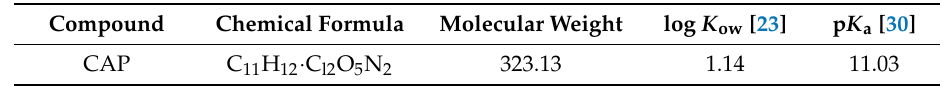
Table 1. Properties of